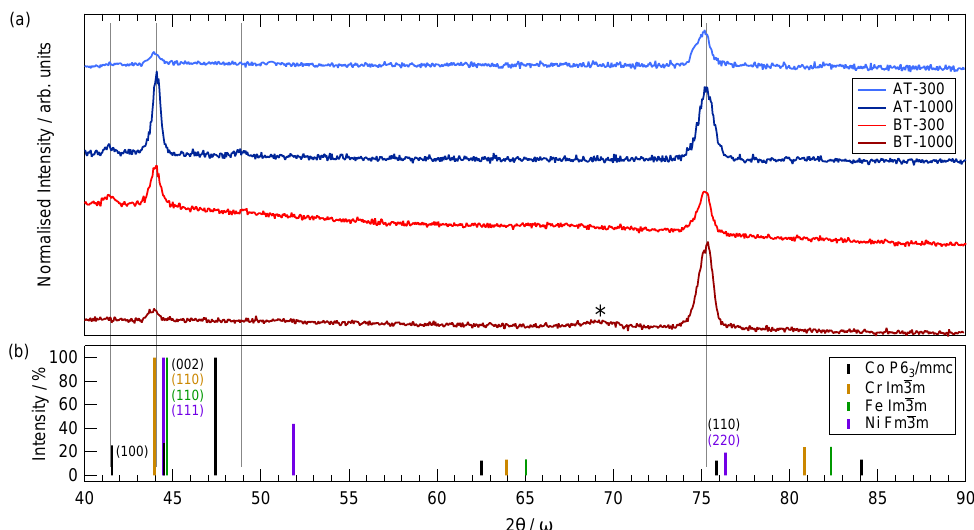
Figure 6. ( a ) X-ray diffraction pattern for the sputtered films deposited from the Alloytarget (blue colour code) and from the Blendtarget (red colour code). The expected XRD signals for pure elements are shown in ( b ). The metallic phases identified in the measurements are marked in the graph. The asterisk marks the residual Si substrate signal.